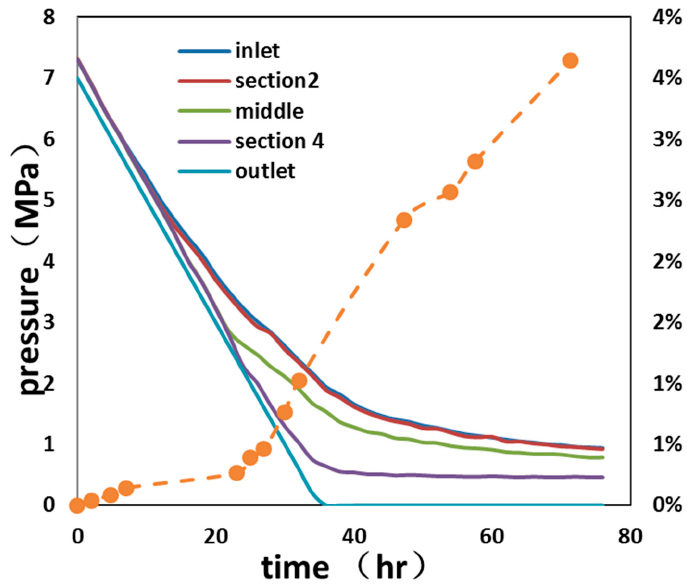
Figure 10. Relationship between pressure changes and oil recovery in Experiment 4—gas cycling part.